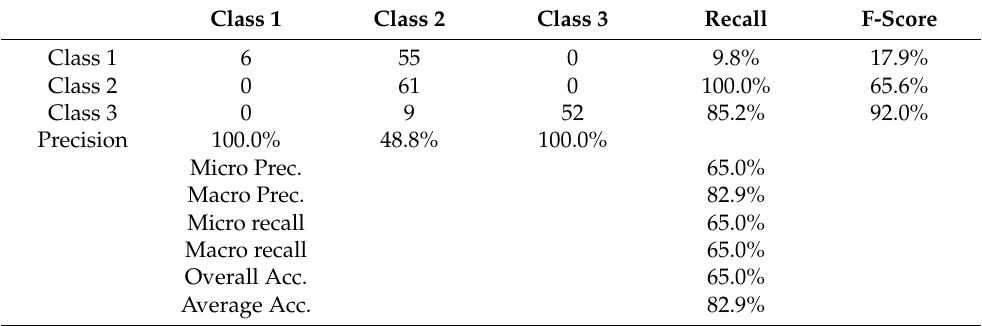
Table 6. ConfusionmatrixassessingCNNtrainedwith“withshadows”images,testedwith“withshadows”.